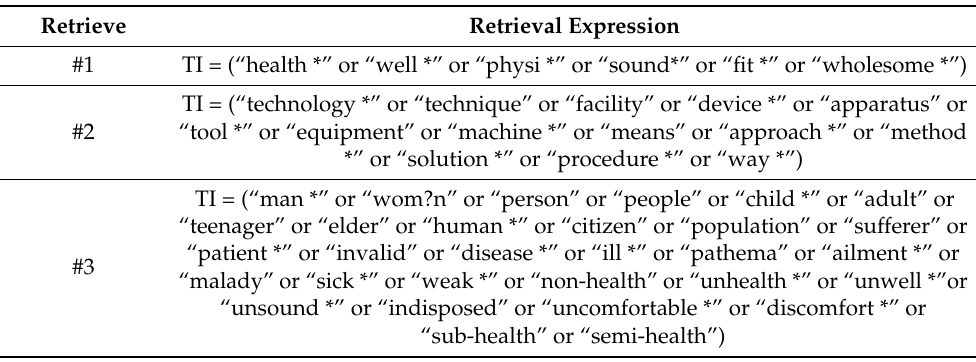
Table 1. Health technology publications retrieval strategy. Retrieve Retrieval